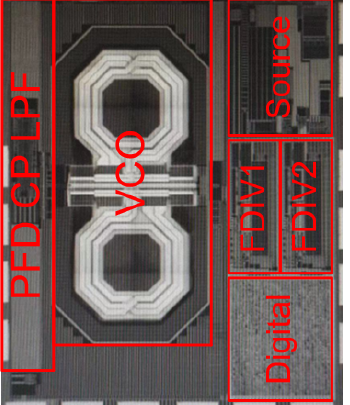
Figure 12. Photograph of proposed